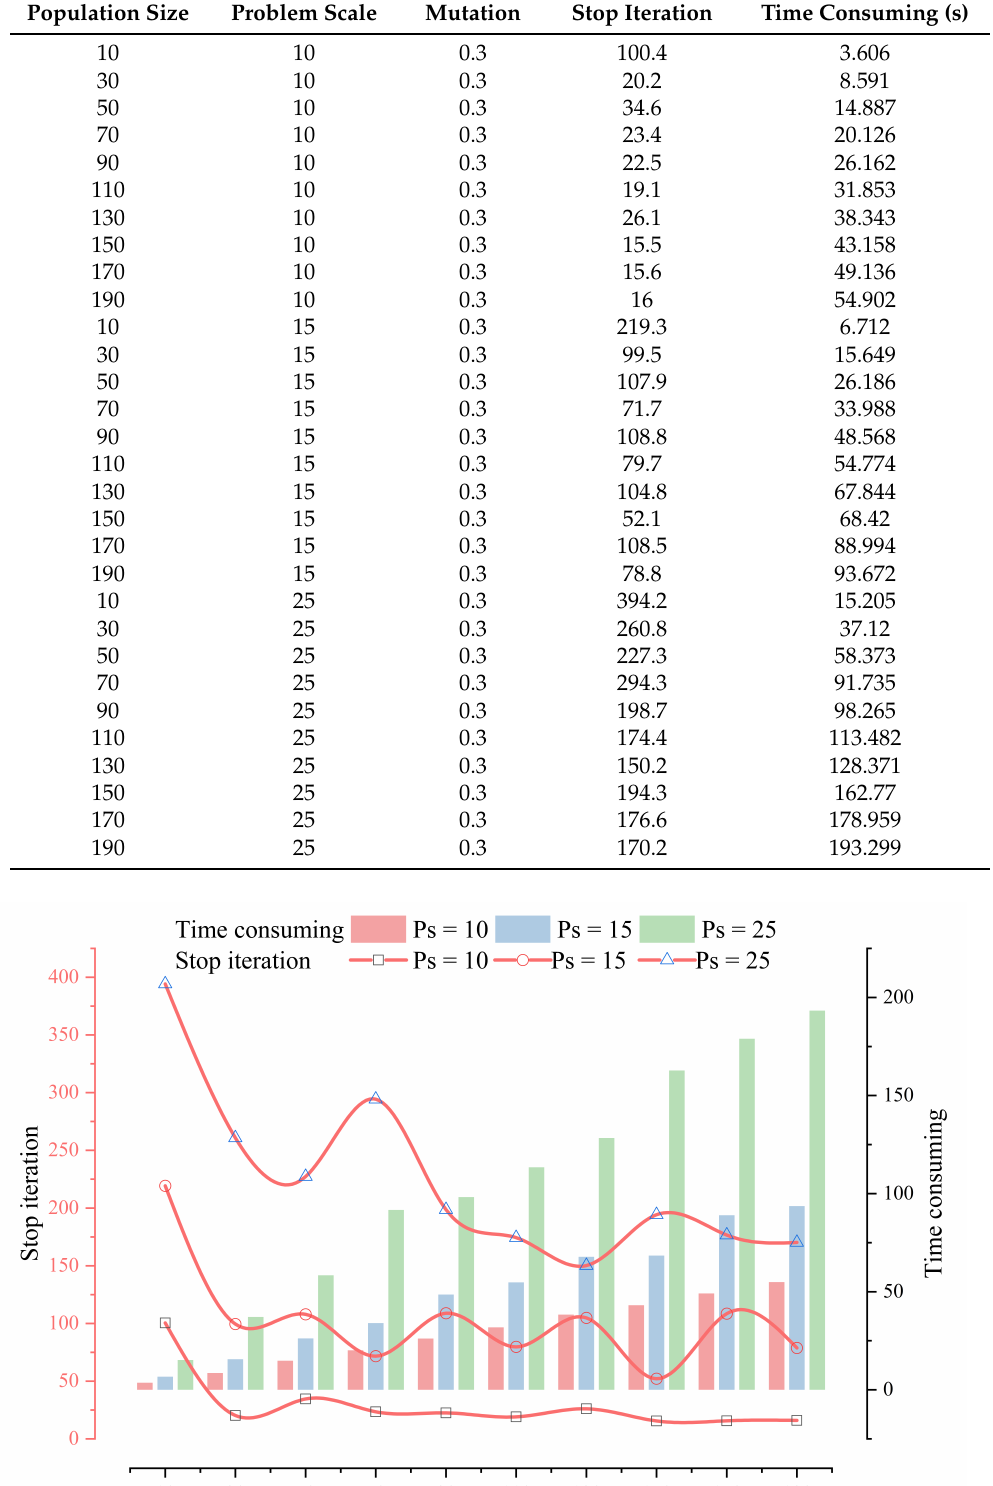
Table 10. Population size sensitivity analysis results.